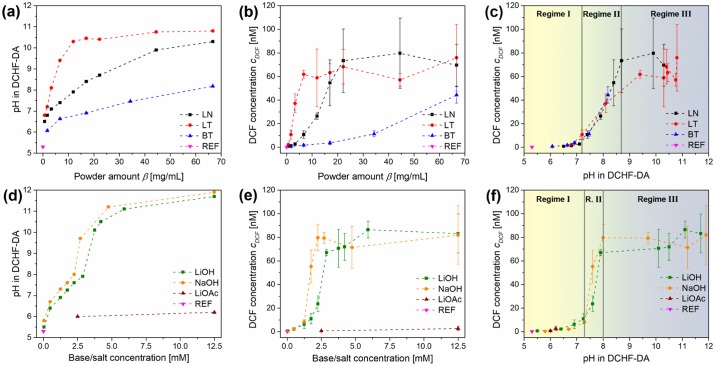
Results with the DCHF-DA-based reaction protocol of the DCF assay for different pyroelectric powders, bases/salts and reference experiments (REF) after thermal treatment.pH-increase with increasing powder amount β (a) or base/salt concentration (d). Measured DCF concentration cDCF with increasing β (b) or base/salt concentration (e). Combination of measured pH and cDCF for powders (c) and bases/salts (f). LN: LiNbO3, LT: LiTaO3, BT: BaTiO3, DCF: dichlorofluorescein, DCHF-DA: dichlorodihydrofluorescein diacetate.